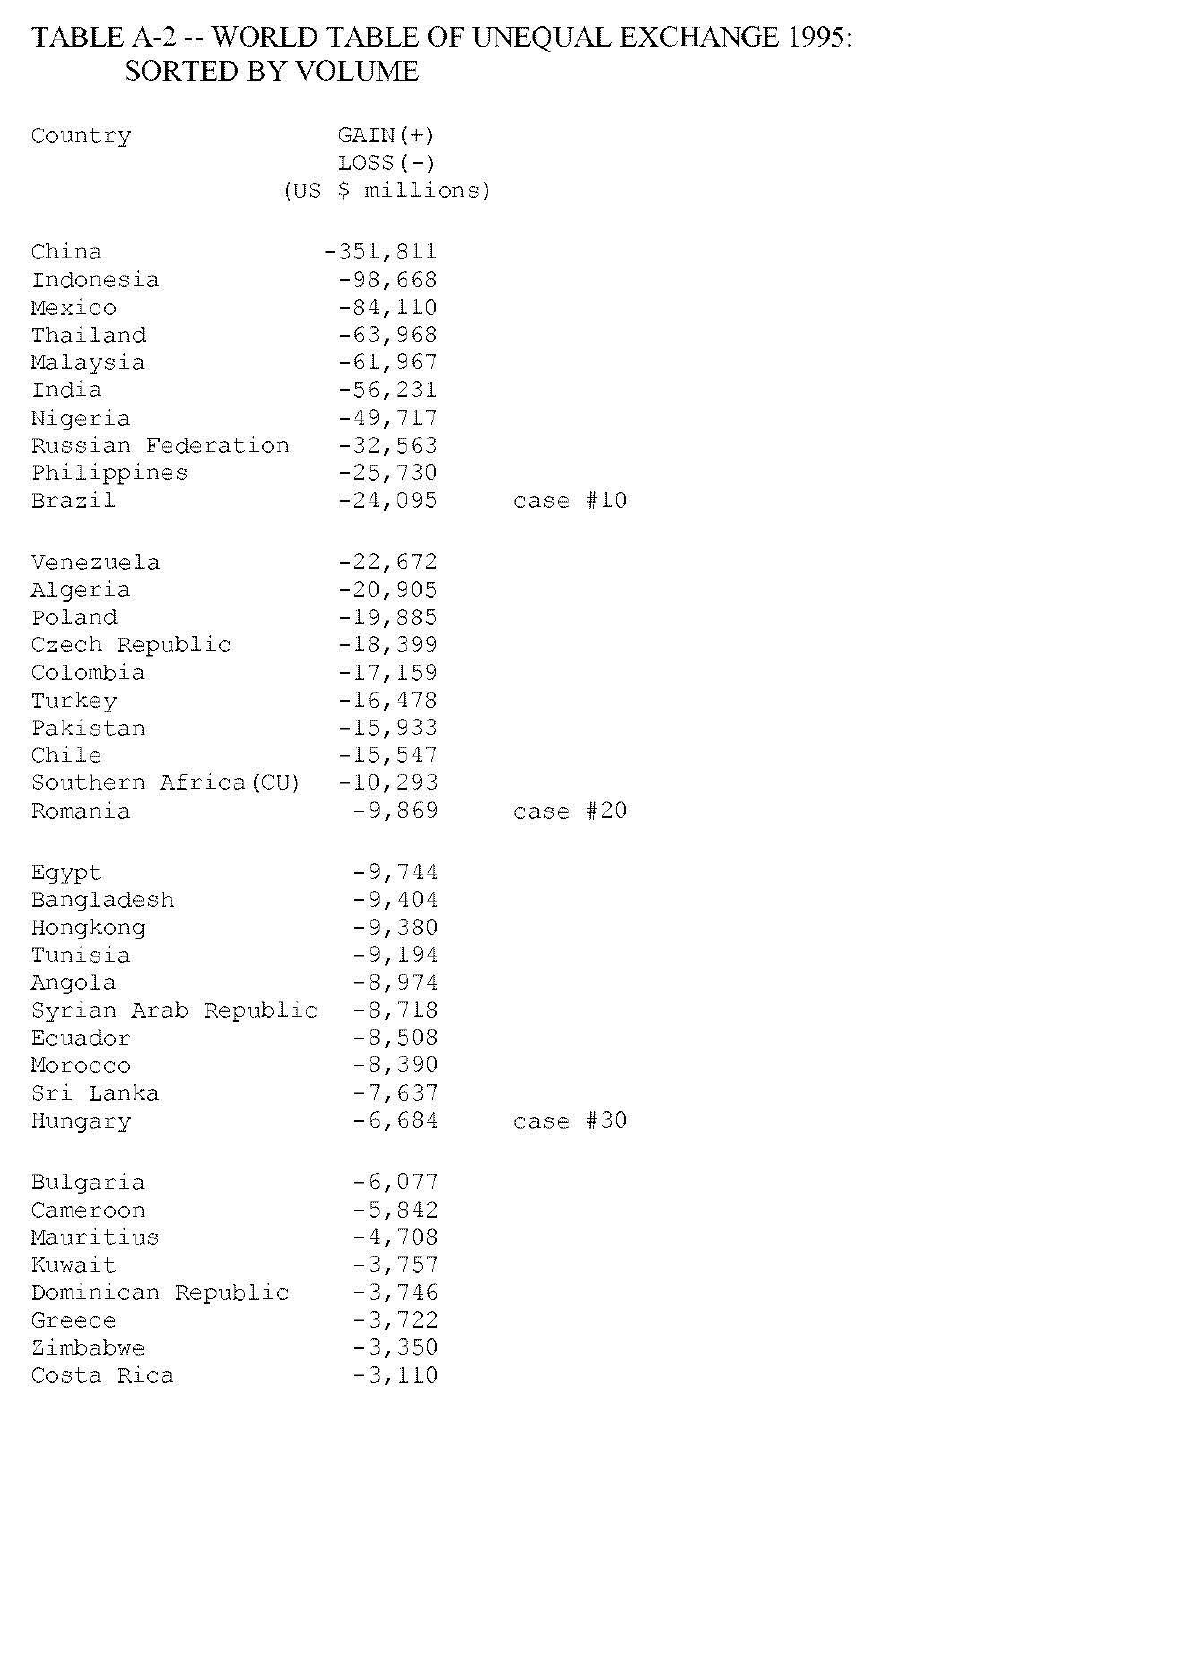
TABLE A-2 -- WORLD TABLE OF UNEQUAL EXCHANGE 1995: SORTED BY